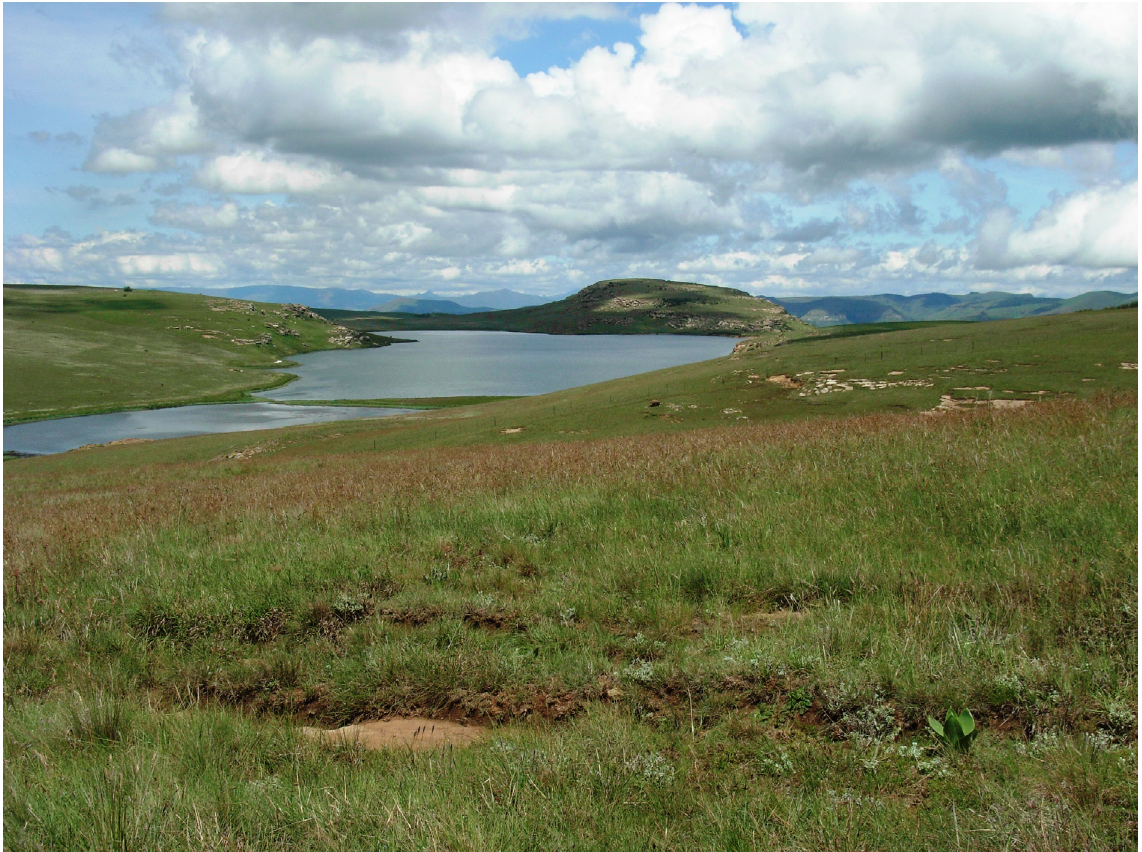
Fig. 6. Matatiele Nature Reserve, showing the mountain summit with the typical habitat of Neoclita pringlei gen. et sp. nov. (photo: Lynette Clennell, Matatiele, 6 Dec.